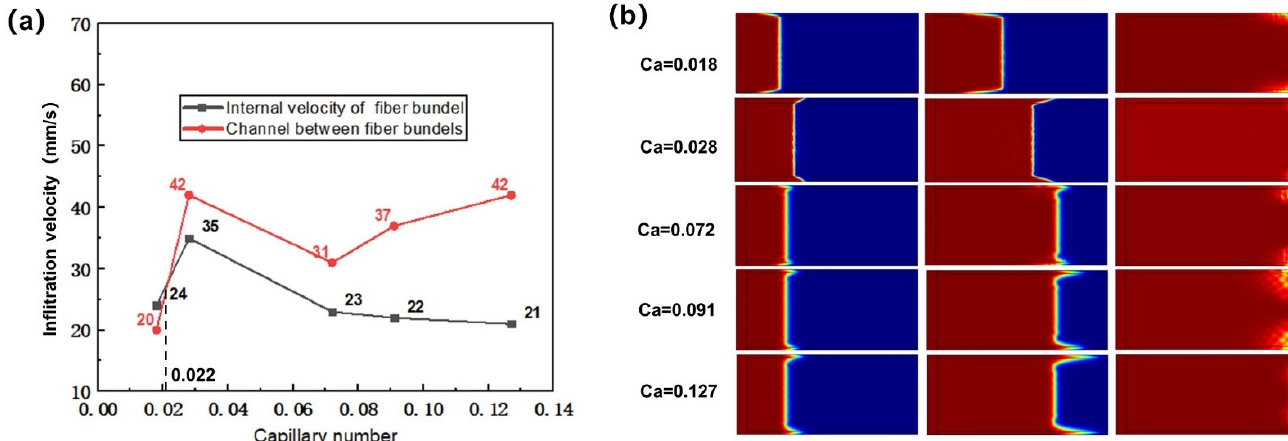
Figure 11. ( a ) Influence of capillary number on flow velocity. ( b ) Influence of capillary number on flow front.